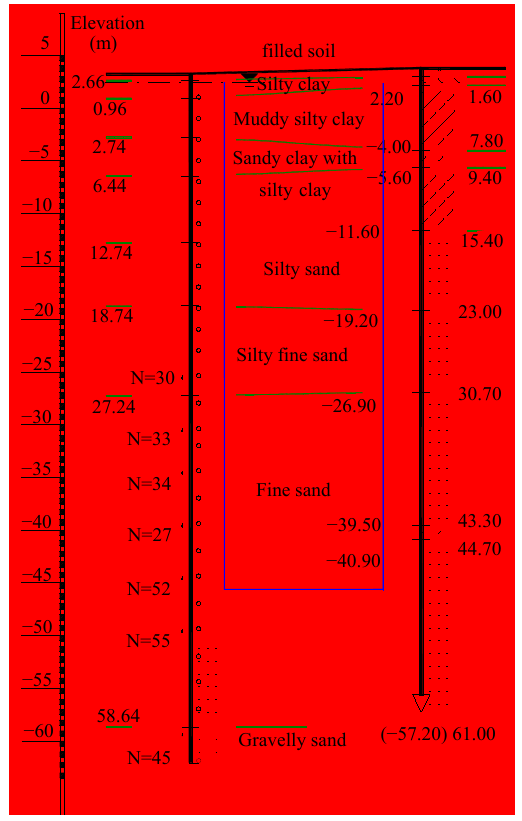
Figure 3. Schematic diagram of the site stratigraphy distribution.